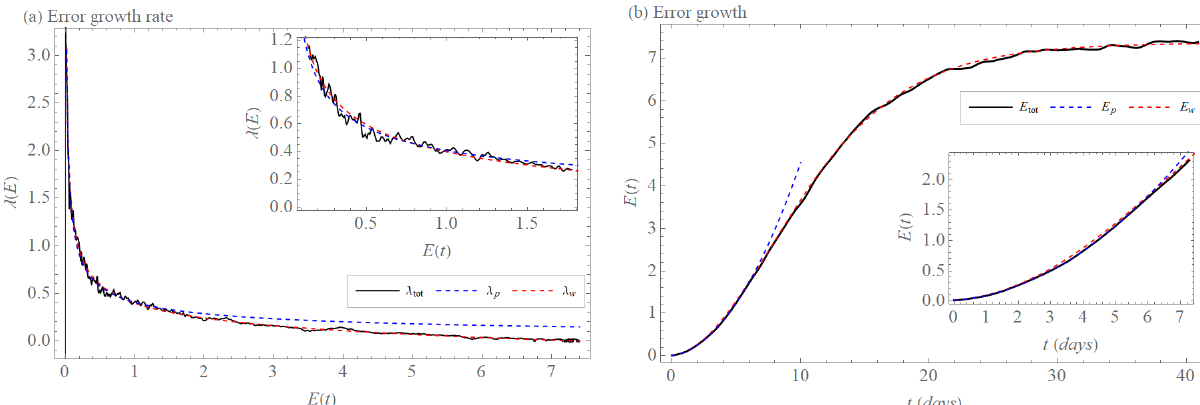
Figure 2. (a) Error growth rate λ tot (E) of the L05-3 system (black). Power law λ p (E) (Eq. 19) with the exponent σ = 0 . 5 and the coefficient a = 0 . 41(units 0 . 5 d − 1 ) ( λ tot , p (E) , blue, dashed) and extended power law λ w (E) (Eq. 26) with the exponent σ = 0 . 47, the coefficient a = 0 . 46(units 0 . 47 d − 1 ), and E ∞ = 7 . 36 (units) ( λ tot , w (E) , red, dashed) that approximate λ tot (E) . (b) Error growth E tot (t) (Eq. 17) (black), solution E tot , p (t) (blue, dashed) of λ tot , p (E) (Eq. 19), and numerical solution of λ tot , w (E) (red, dashed).